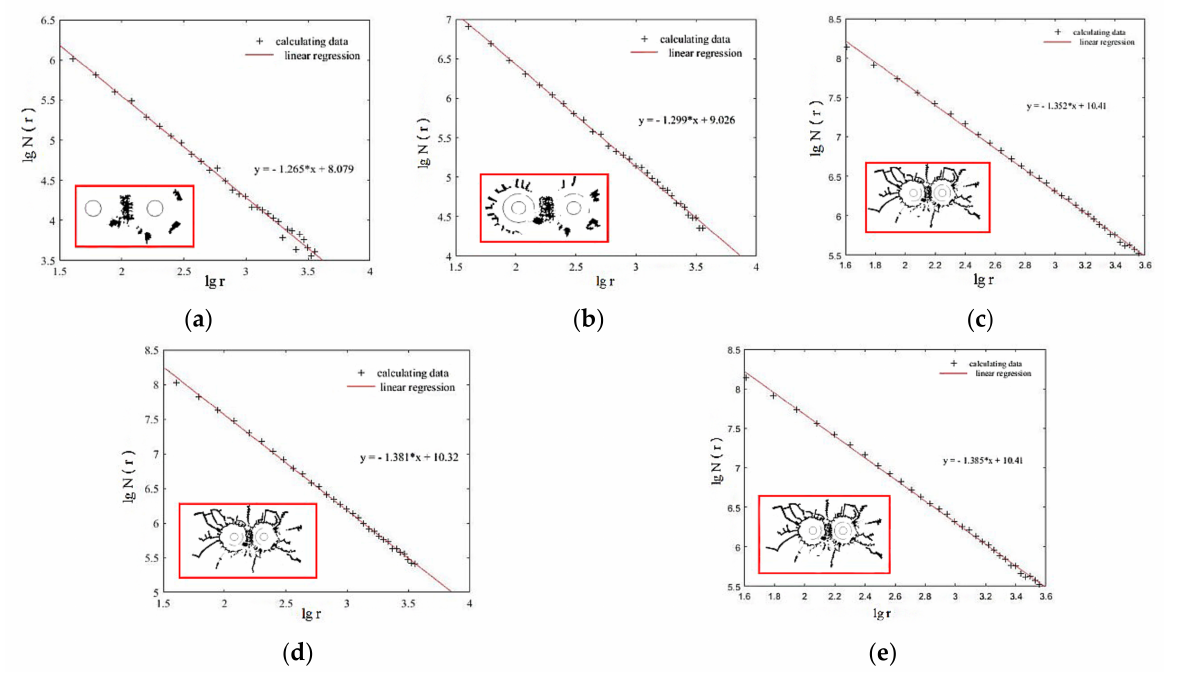
Figure 9. The 130 mm aperture, 910 mm aperture fractal dimension and damage evolution process. ( a ) At 1 us after explosion; ( b ) 2 us after explosion; ( c ) 3 us after explosion; ( d ) 4 us after explosion; ( e ) 5 us after explosion.